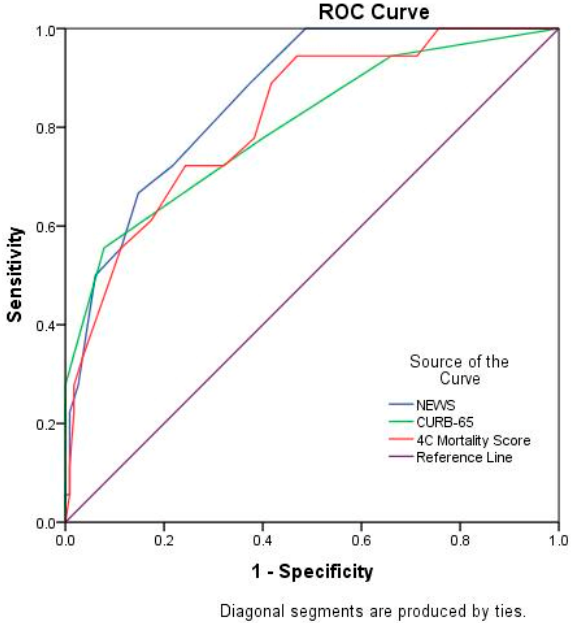
Figure 1. Receiver operating characteristic curve of clinical risk scores in predicting mortality. In terms of mortality risk prediction, the NEWS performed best, with an AUC of 0.86. The CURB-65 score performed poorly, with an AUC of 0.80 (Table 3). Table 3. Accuracy of 4C Mortality Score, NEWS, and CURB-65.